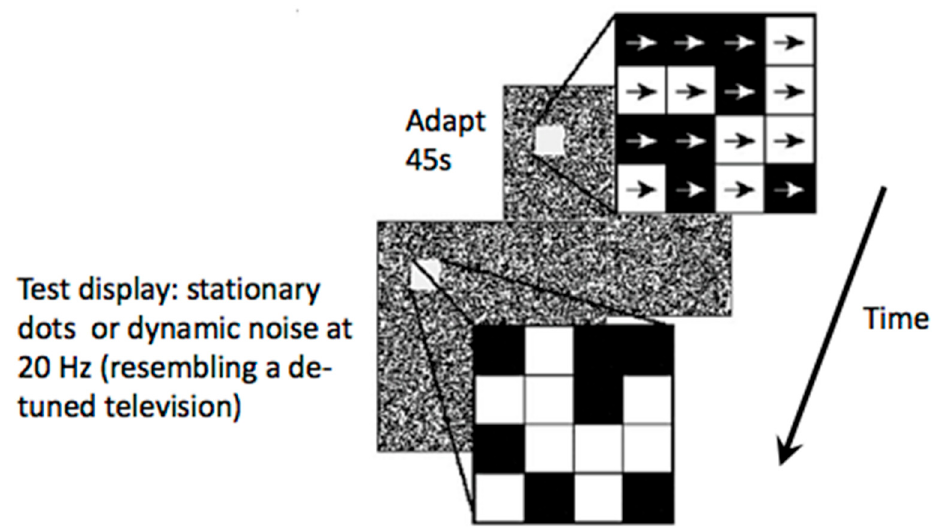
Figure 2. An example of the displays used to assess prolonged motion after-effects in migraine. Adapted from Shepherd [10,11].